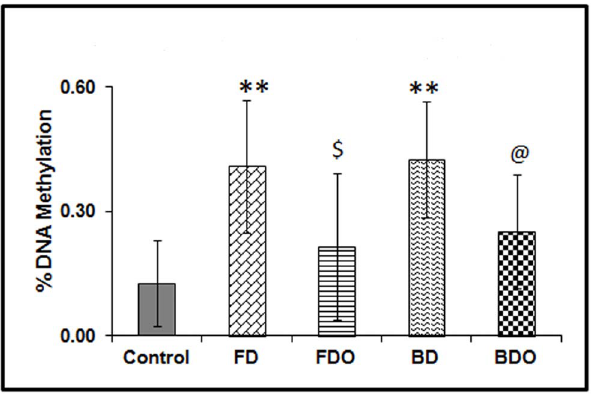
Figure 1. Pup liver global DNA methylation in different groups. Data in each group is on 4 males and 4 females. The treatment groups were compared with the control group by One Way ANOVA and the post-hoc least significant difference test. Results are presented as mean 6 SD (standard deviation). **p , 0.01 as compared to control; $ p , 0.05 as compared to FD group; @ p , 0.05 as compared to BD group. Control